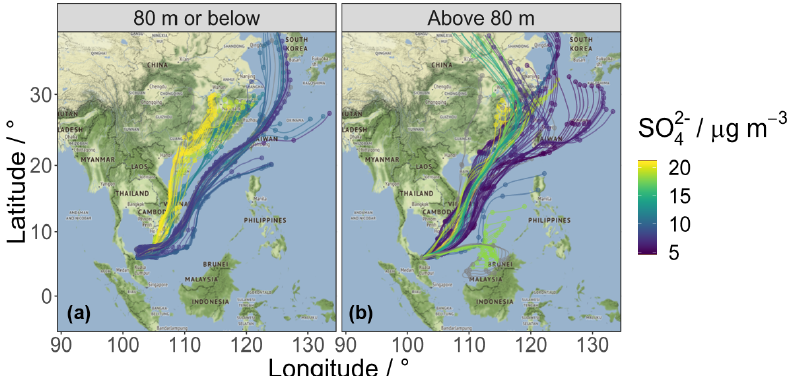
Figure 6. The 7-day HYSPLIT backward air mass trajectories centred on the Bachok research station between 18 January and 7 Febru- ary 2014. The back trajectories are coloured by the concentration of SO 2 − (µgm − 3 ). Trajectories with a mean height of 80m or below are 4 shown in panel (a) and trajectories with a mean height greater than 80m are shown in panel (b) .